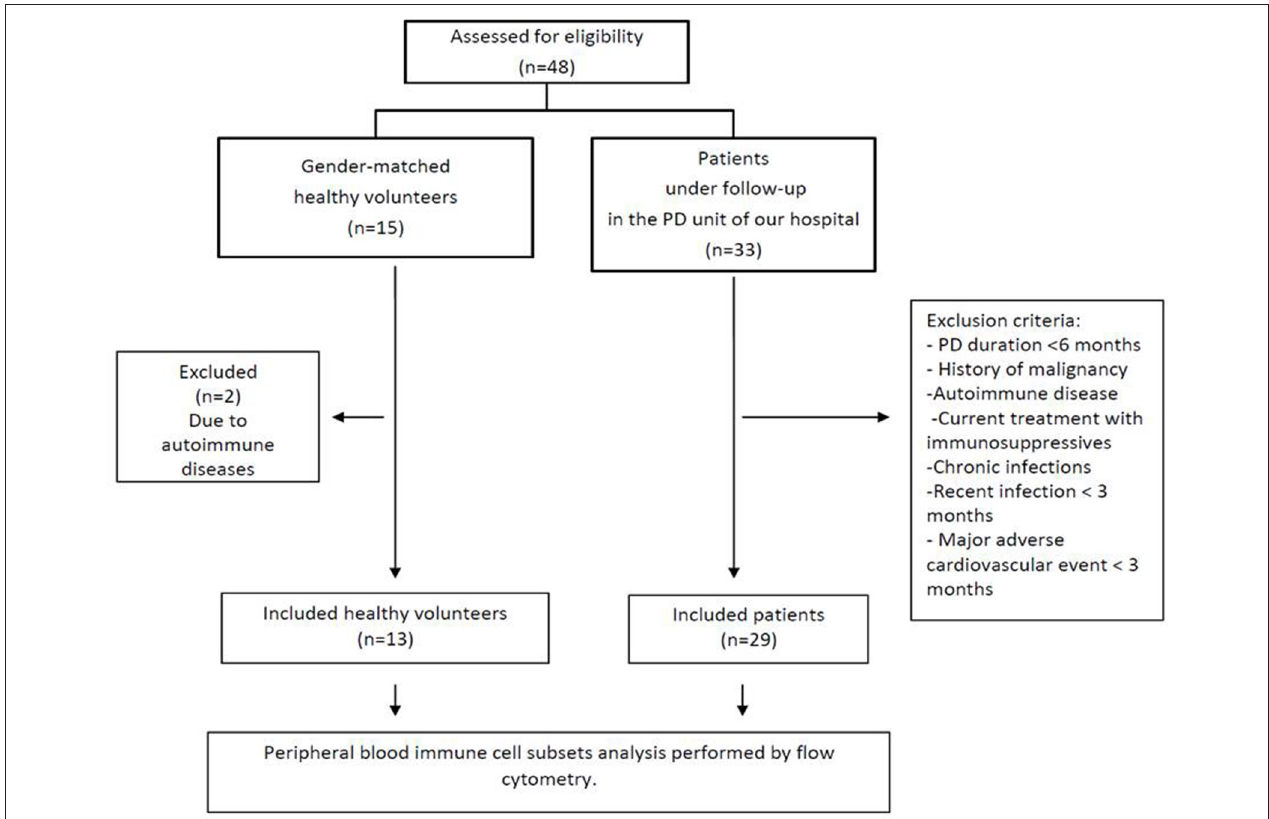
FIGURE 1 | Flowchart of the study.